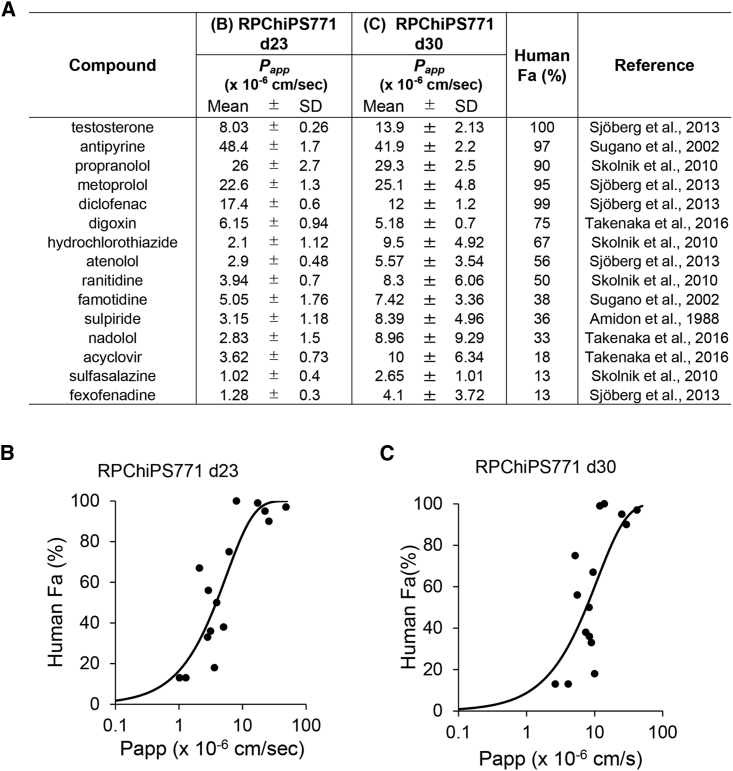
A Good Correlation of in vitro Papp in hiPSC-derived Enterocyte-like Cells with Fa Values of Test Drugs in Humans(A) Human RPChiPS771 iPSC-derived enterocytes matured using M3-2 medium were used for evaluating the apparent permeability of 15 test drugs on day 23 (B) or D30 (C) of differentiation. Drugs with known Fa values and the references used in this study are shown in the list. Data are expressed as the mean ± SD (n = 4; n, number of duplicates) (B and C). The mean values of Papp against Fa of the drugs are plotted, which showed a good correlation and sigmoidal relationship with the coefficient of determination R2 = 0.749 (B), or R2 = 0.553 (C).